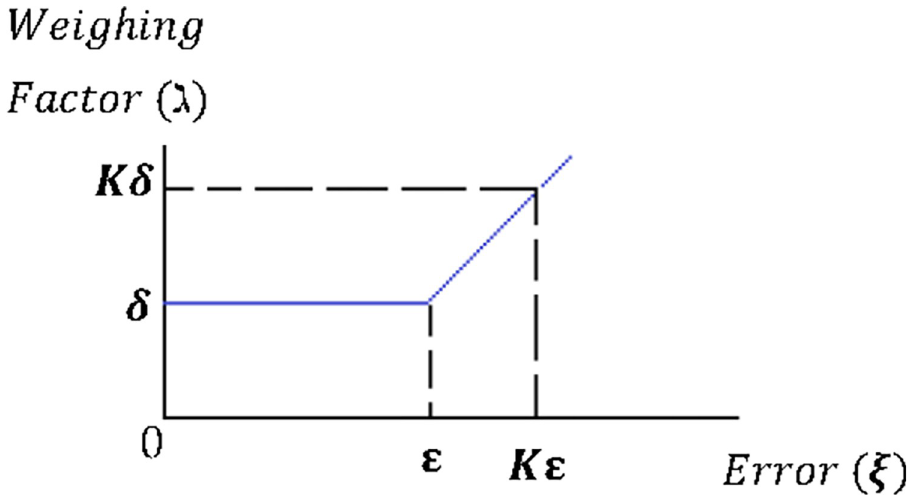
Fig 9. Weighing factor as a function of the